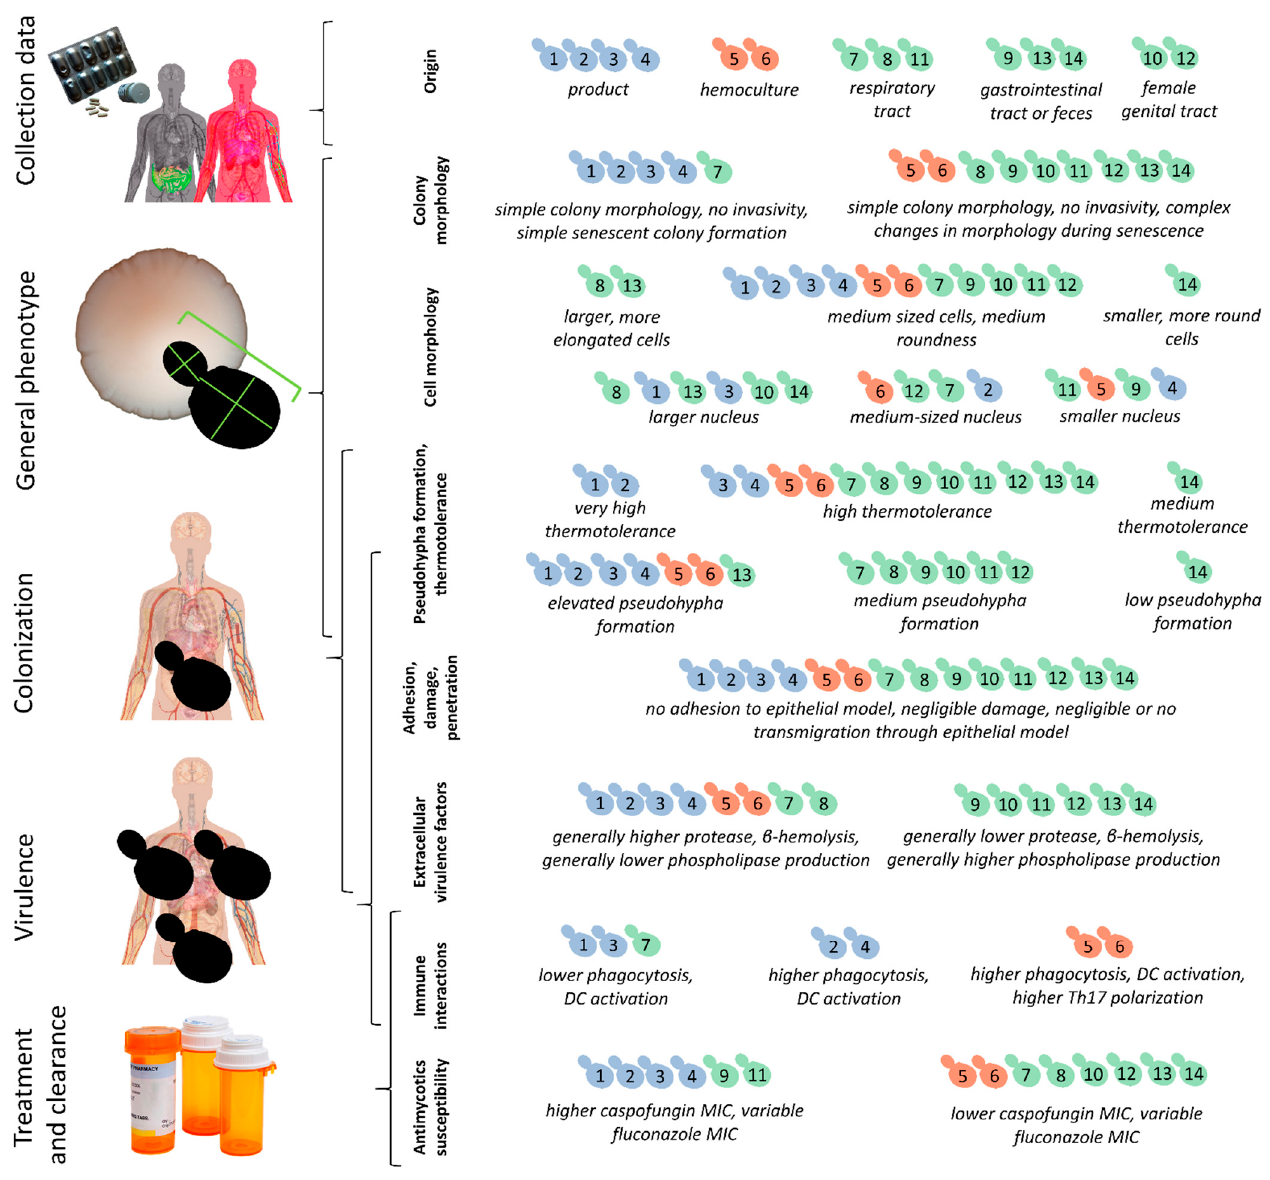
Figure 6. Summary of the clustering of S. ‘boulardii’ isolates based on phenotypic differences, virulence factors, interactions with the epithelial model and with immune cells, and antimycotics susceptibility. Left: main steps and features of potential probiotic infections and probiotic yeasts in general. Right: individual isolates (blue: commercial, red: mycosis, green: non-mycosis) numbered according to Table 1, grouped into distinct categories based on simple comparisons, PCA, and phenotypic clustering.